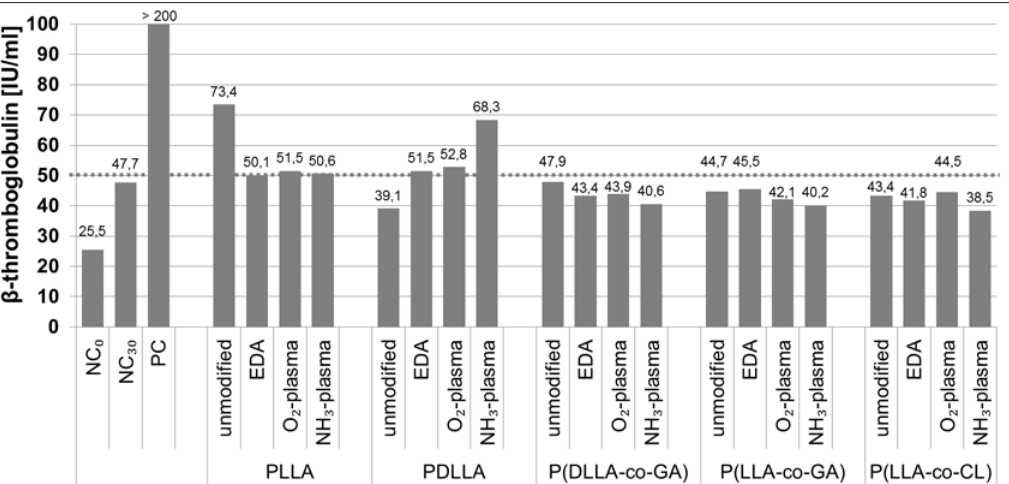
Fig 9. Plasma β -thromboglobulin concentrations after incubation with unmodified and modified polymers. The dotted line represents the upper limit of normal β -thromboglobulin concentration. NC = negative control, PC = positive control.